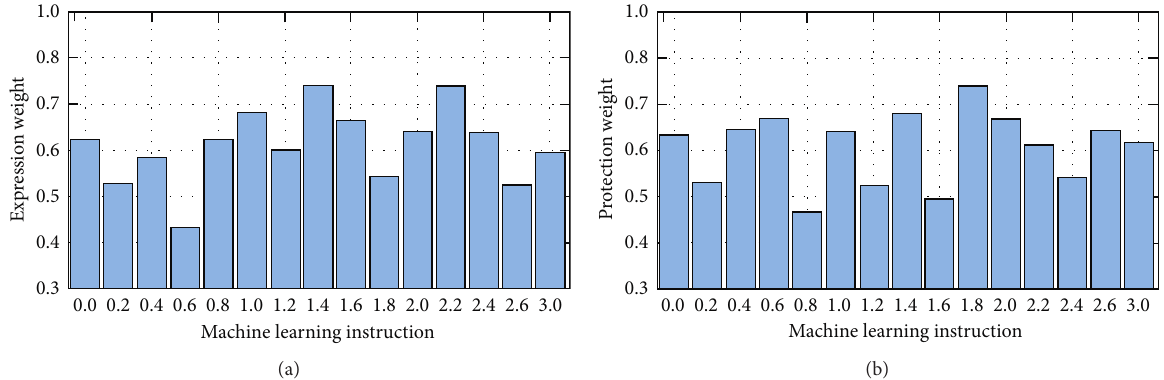
Figure 5: Relationship between expression weight and machine learning instruction in the intellectual property expression (a) and protection